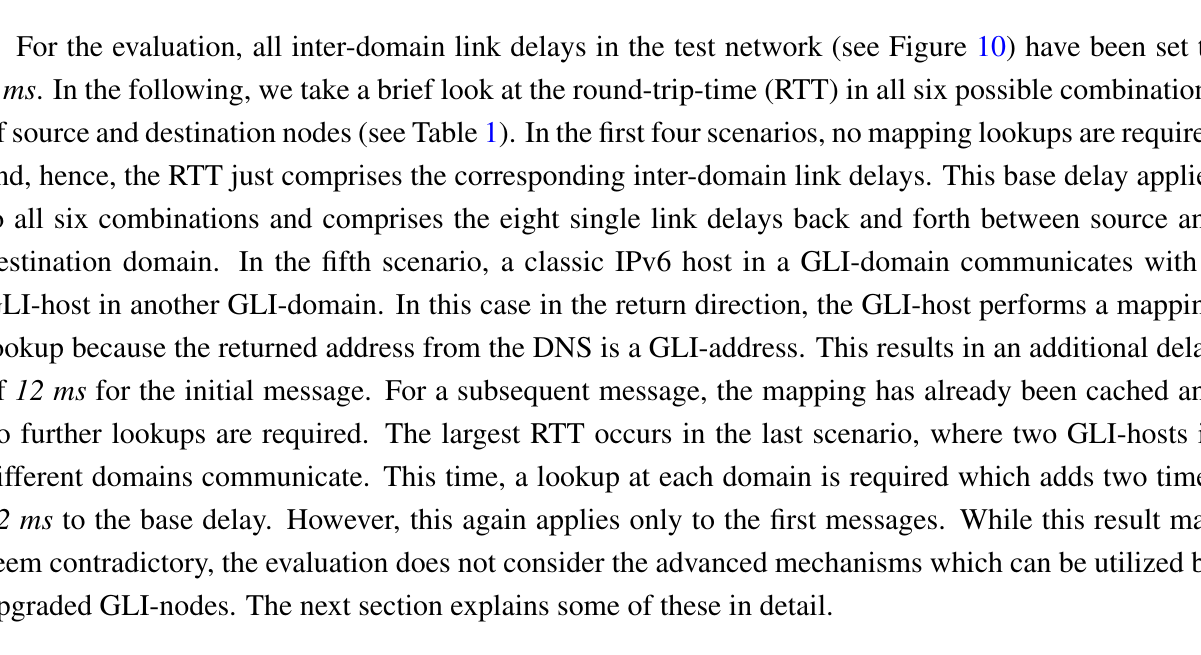
Table 1. Comparison of initial and second RTT between classic hosts (H (H ) in GLI-domains (D GLI